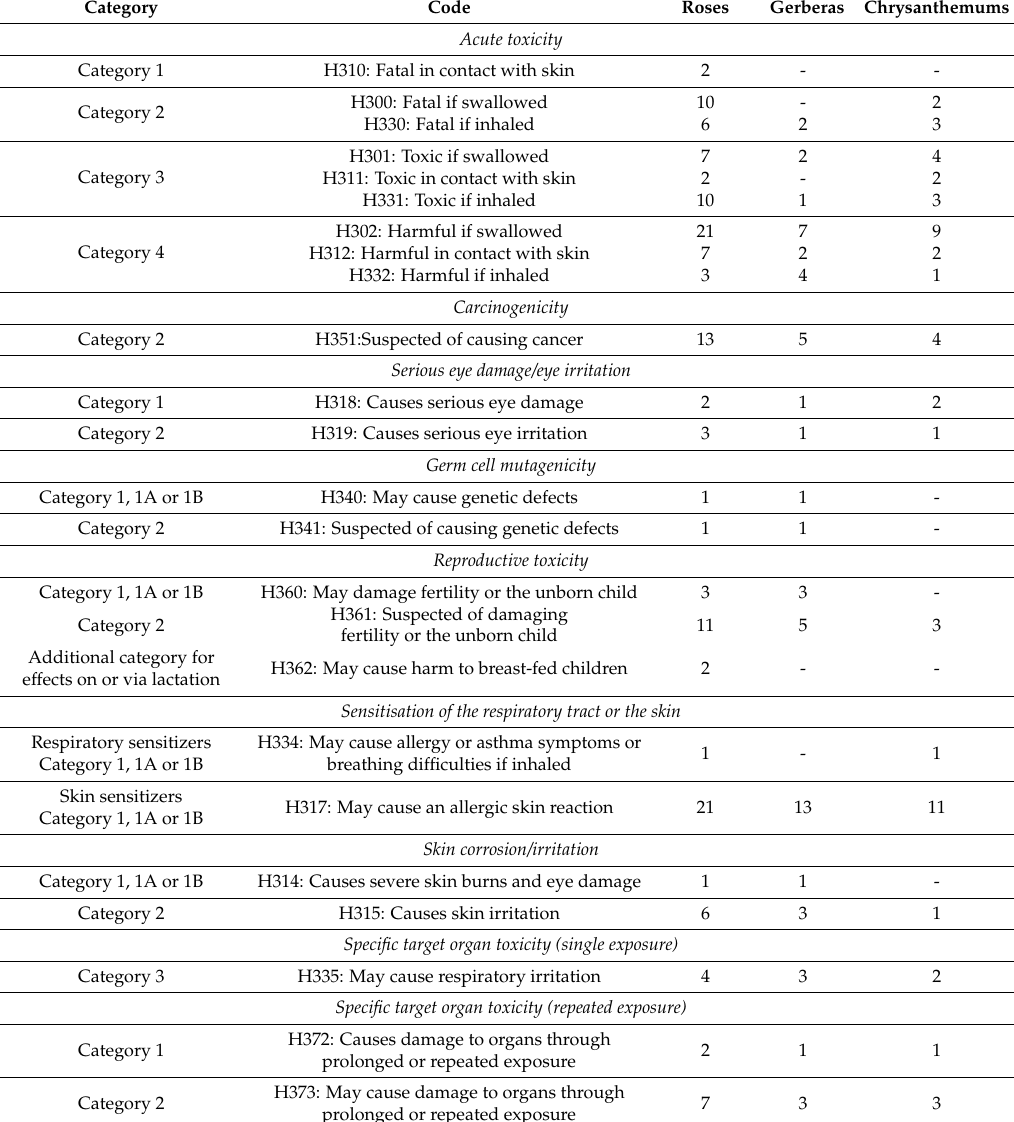
Table 8. Number of active substances detected on the various cut flower species classified in each hazard category according to CLP regulation (with the corresponding code of hazard (only relevant categories for florist exposure are listed)